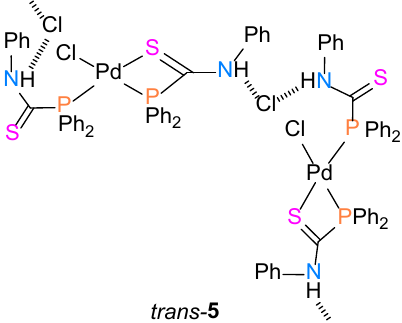
Figure 6. Inter-molecular hydrogen bonds (hash line) for trans- 5 .